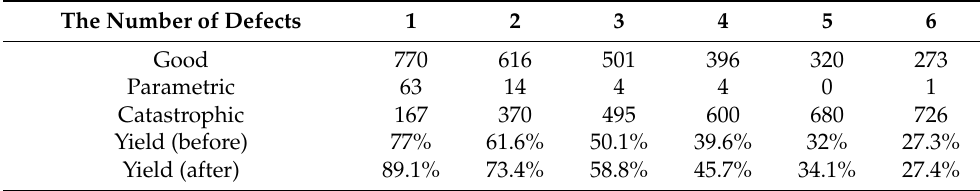
Table 5. Self-test, self-calibration and fault-repair models before and after